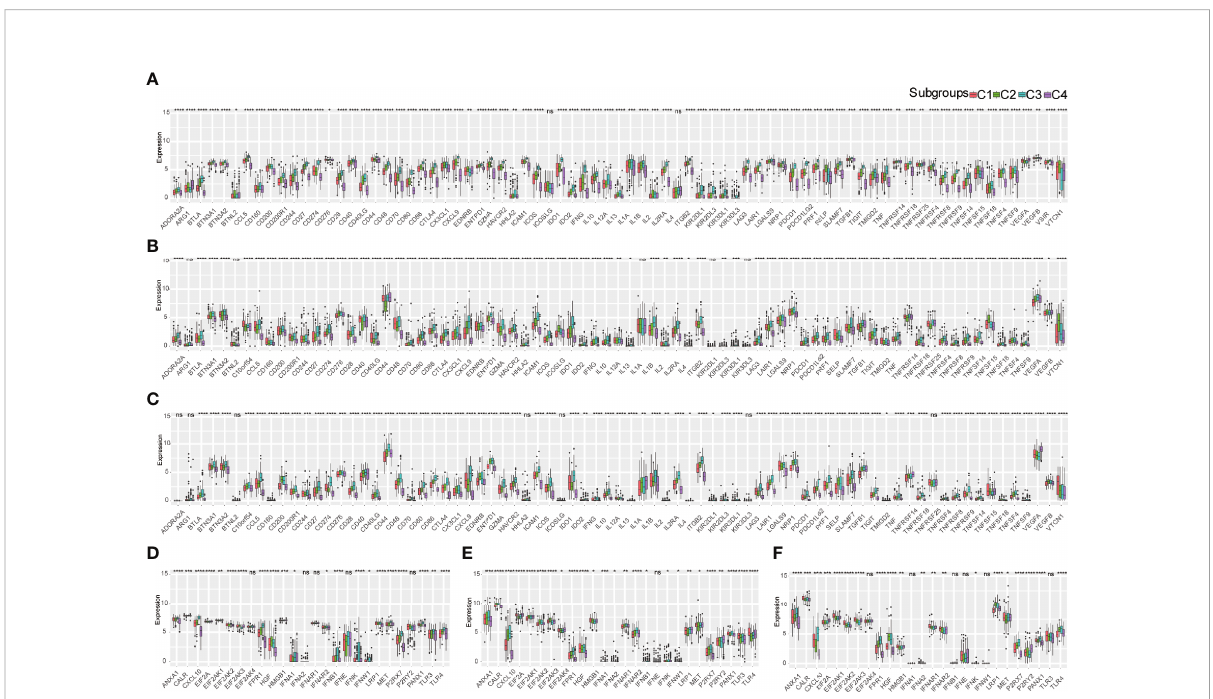
FIGURE 3 Expression pattern of immune molecules in the TME of bladder urothelial carcinoma according to immune subtypes. (A-C) Differential expression of immune checkpoints in the four immune subtypes in TCGA-BLCA cohort (A) , E-MTAB-4321 cohort (B) , and IMVigor210 cohort (C) . (D-F) ICD expression in the four immune subtypes in TCGA-BLCA cohort (D) , E-MTAB-4321 cohort (E) , and IMVigor210 cohort (F) . ns, p ≥ 0.05; *p<0.05; **p<0.01; ***p<0.001; and